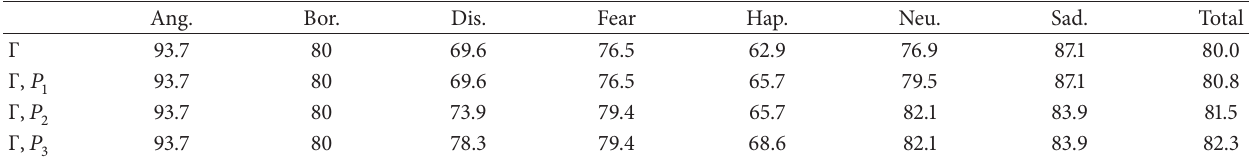
Table 3: Performance evaluation using different feature sets.